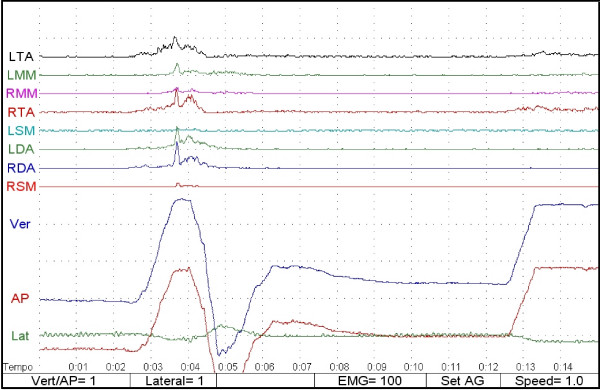
Swallowing with occlusal contact (SOC).